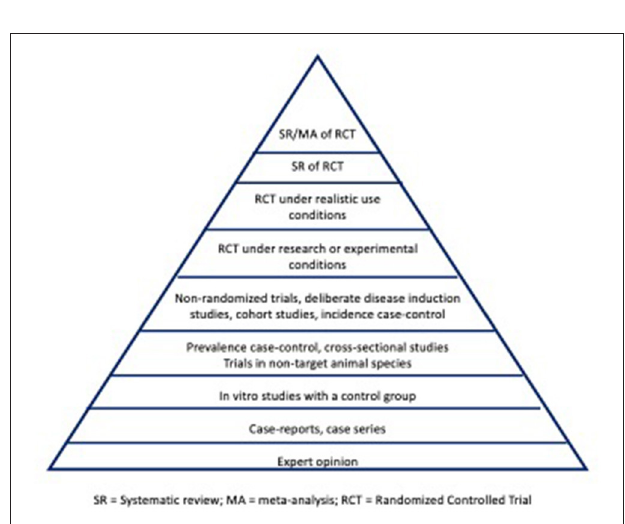
FIGURE 1 | Illustration of an evidence pyramid hierarchy for addressing intervention studies in veterinary medicine. SR, systematic review; MA, meta-analysis; RCT, randomized controlled